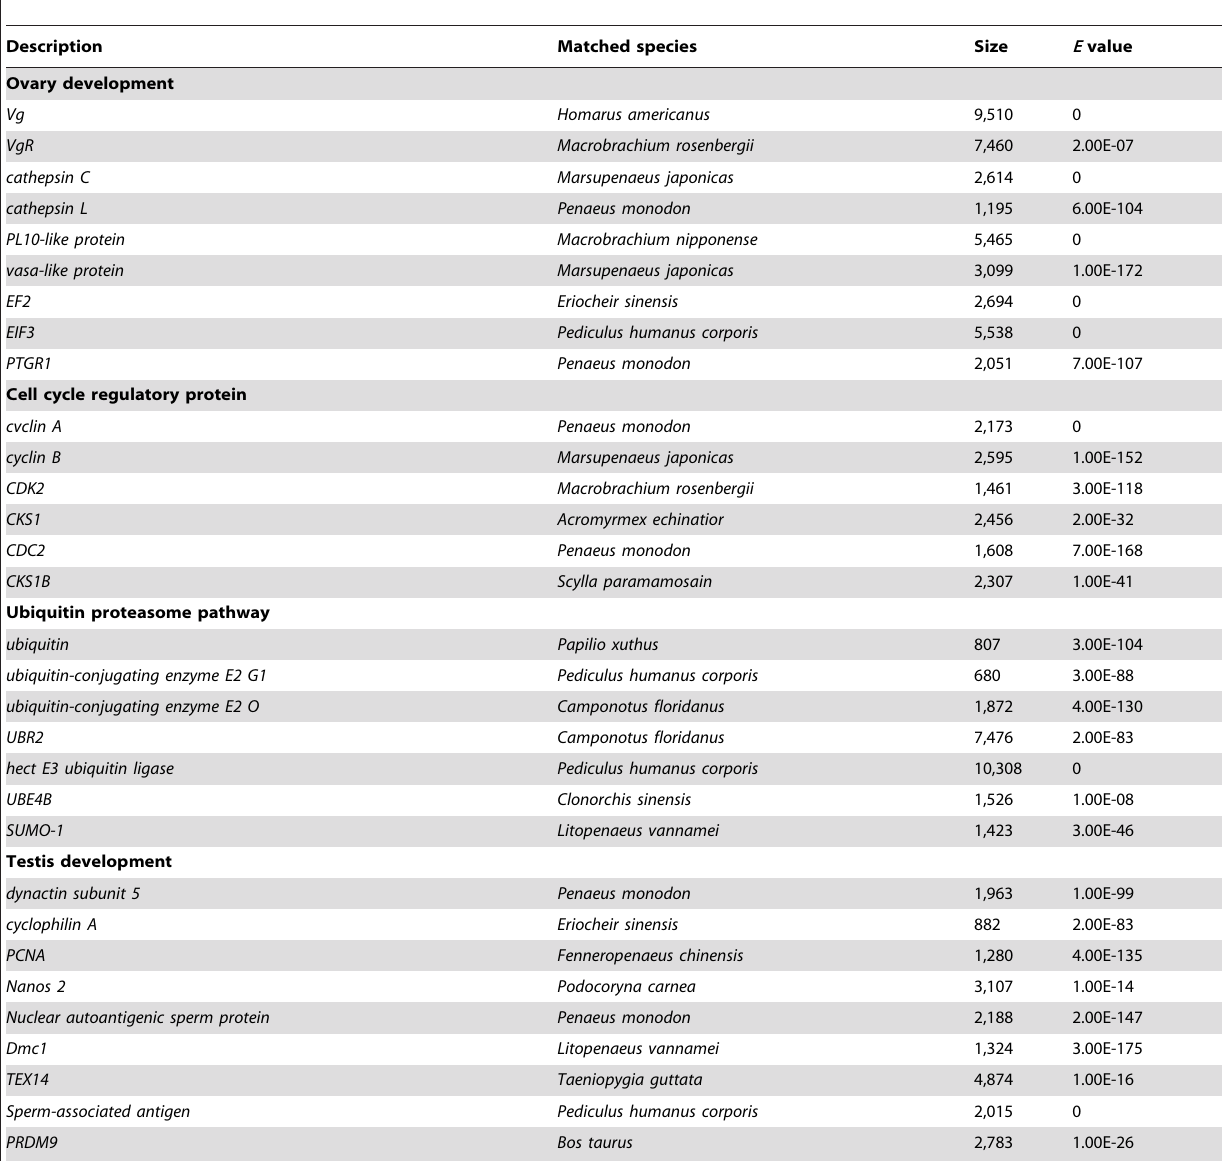
Table 2. List of genes known to be involved in gonad development of P. clarkii transcriptome.